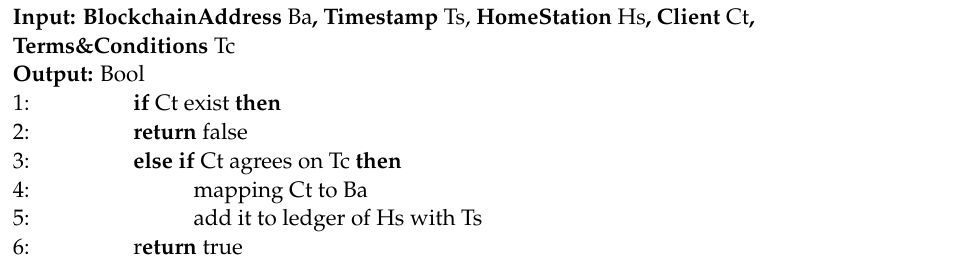
Algorithm 1: Create_Contract: Algorithm that create a smart contract in blockchain network